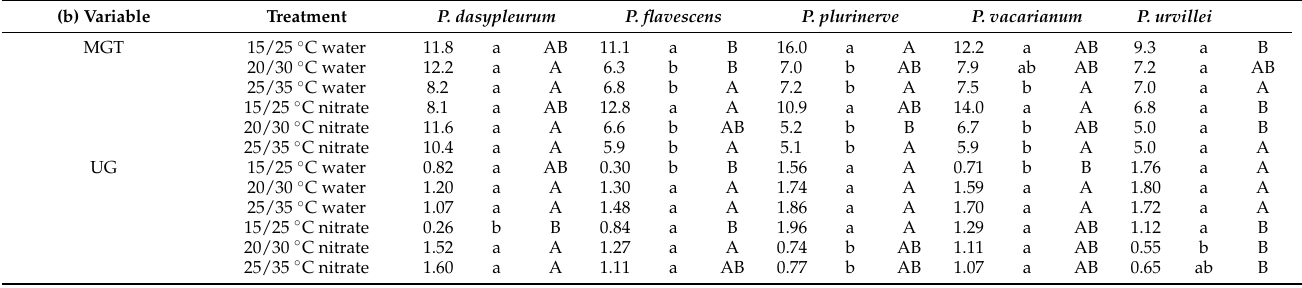
( a ) Lowercase letters indicate differences among stratification treatments within each species. Uppercase letters indicate differences among species within each stratification treatment ( p < 0.05). ( b ) Lowercase letters indicate differences among temperature regimes within each species and nitrate addition combination. Uppercase letters indicate differences among species within each temperature regime and nitrate addition combination. Bold numbers indicate differences between distilled water and nitrate addition within each temperature regime and species combinations ( p < 0.05).